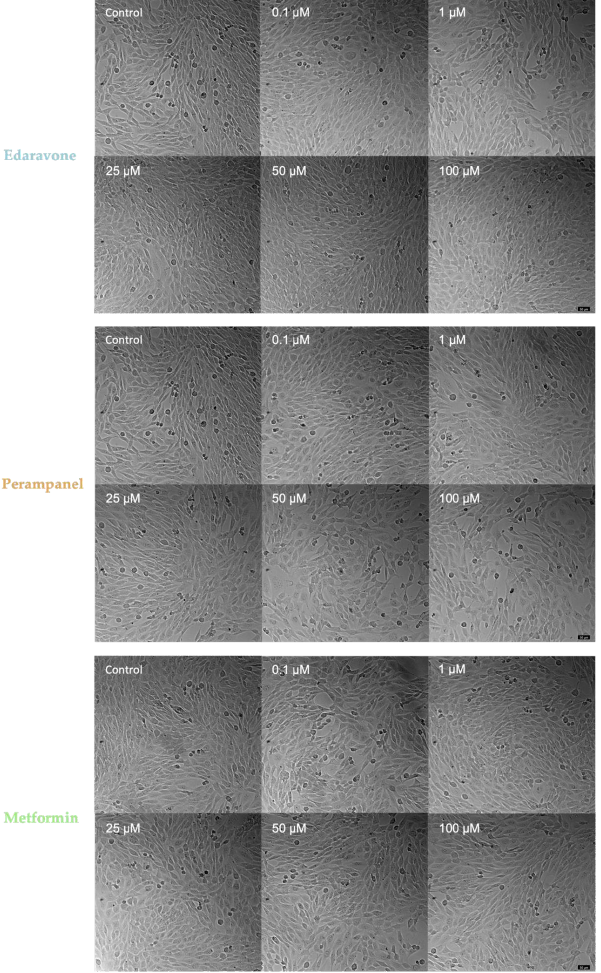
Figure 3. Microscopic representative images of HT-22 control cells and cells after 48-h exposure to concentrations ranging from 0.1 to 100 µ M of edaravone, perampanel, and metformin. Images of cell morphology were obtained on a Leica microscope equipped with Leica LAS X imaging software v3.7.4 (Leica Microsystems, Wetzlar, Germany) from three independent experiments. Scale bar: 50 µ m.